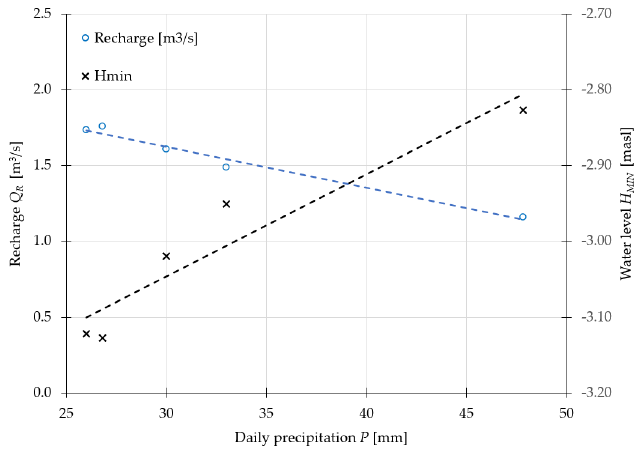
Figure 9. Scatterplot of recharge Q R and H min against daily rainfall for 25 mm/day < p < 50 mm/day.